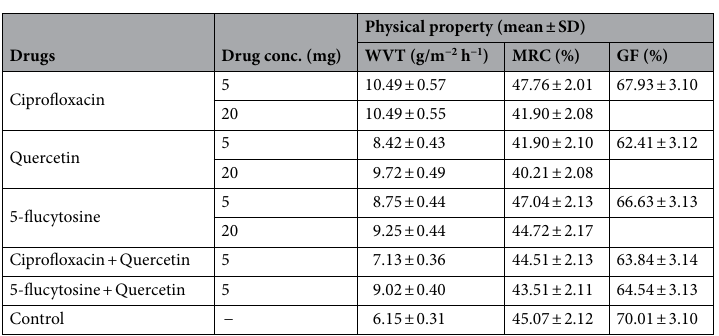
Table 4. Physical property of the